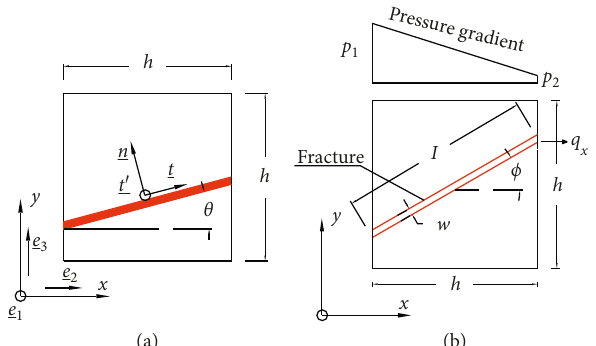
Figure 3: Inclined fracture cell with its local coordinate system is characterized by an inclination angle θ ( θ ∈ [ 0 , π ]) with respect to the global reference Oxyz (case 2D plane strain model with t ′ � e 1 ) (a); the fracture cell considered in the hydraulic problem